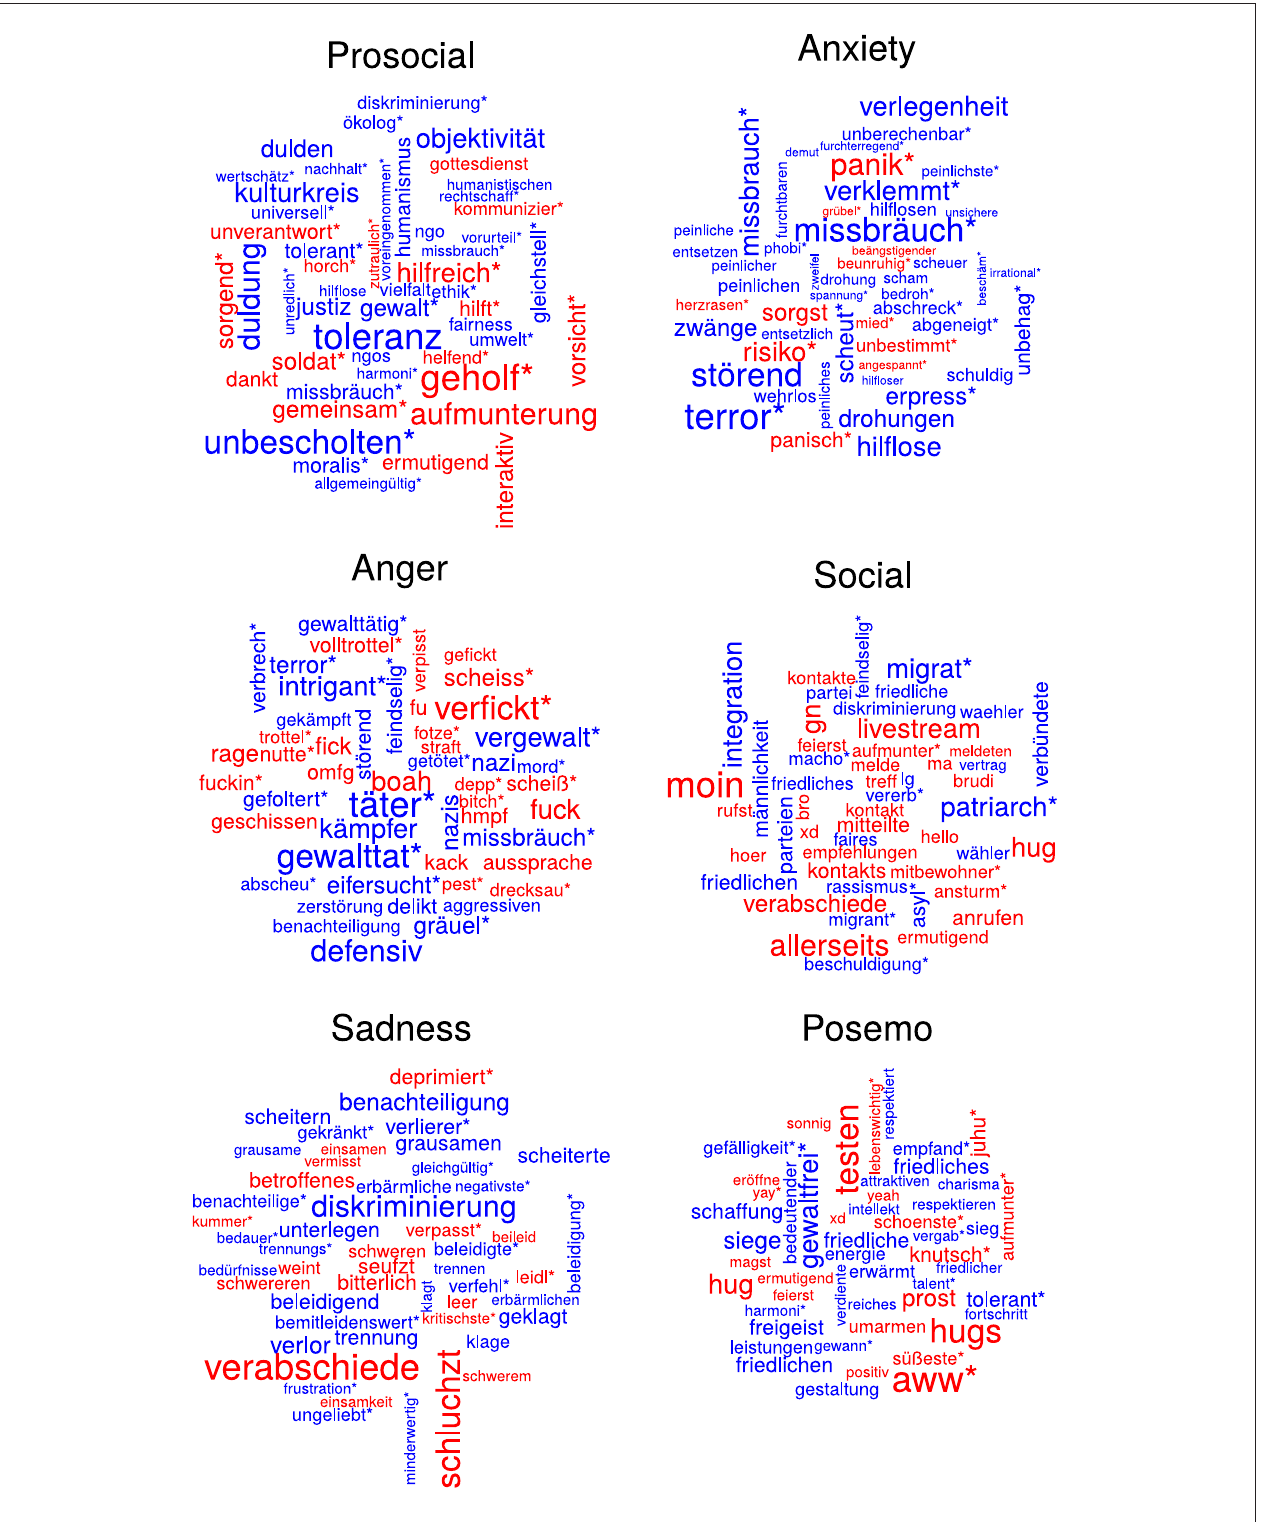
FIGURE 2 | Wordclouds for posts on derstandard.at showing the matched words in each category. Size corresponds to the magnitude and color to the direction of change: blue and red mean less and more prevalent in the COVID-19 livetickers than in the normal articles of 2019, respectively. To be included, dictionary terms have to appear at least 10 times in both